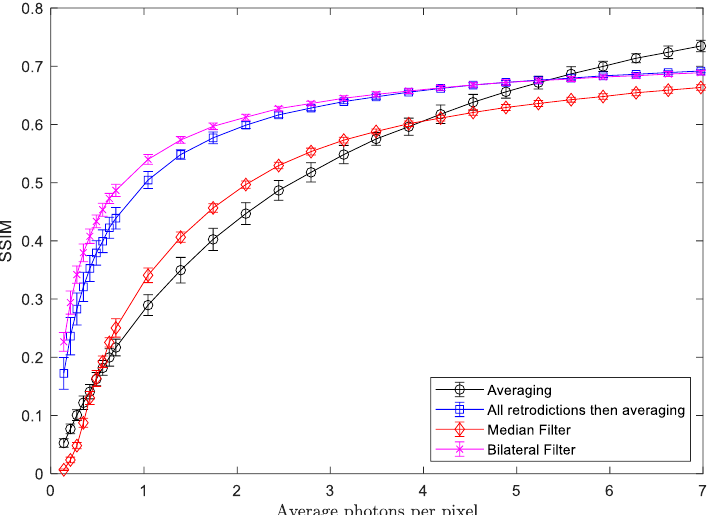
Figure 7. Average of SSIM for 100 image reconstructions of the test target image by the averaging method (black circles), retrodiction and averaging (blue squares), median filtering of the averaged image (red diamonds) and bilateral filtering of the averaged image. Standard deviation of the SSIM is shown with error bars. Note that there is some uncertainty in the number of photons per pixel as each of the 100 inputs for every data point is variable; however, the error bars for this would be smaller than the icon used for each